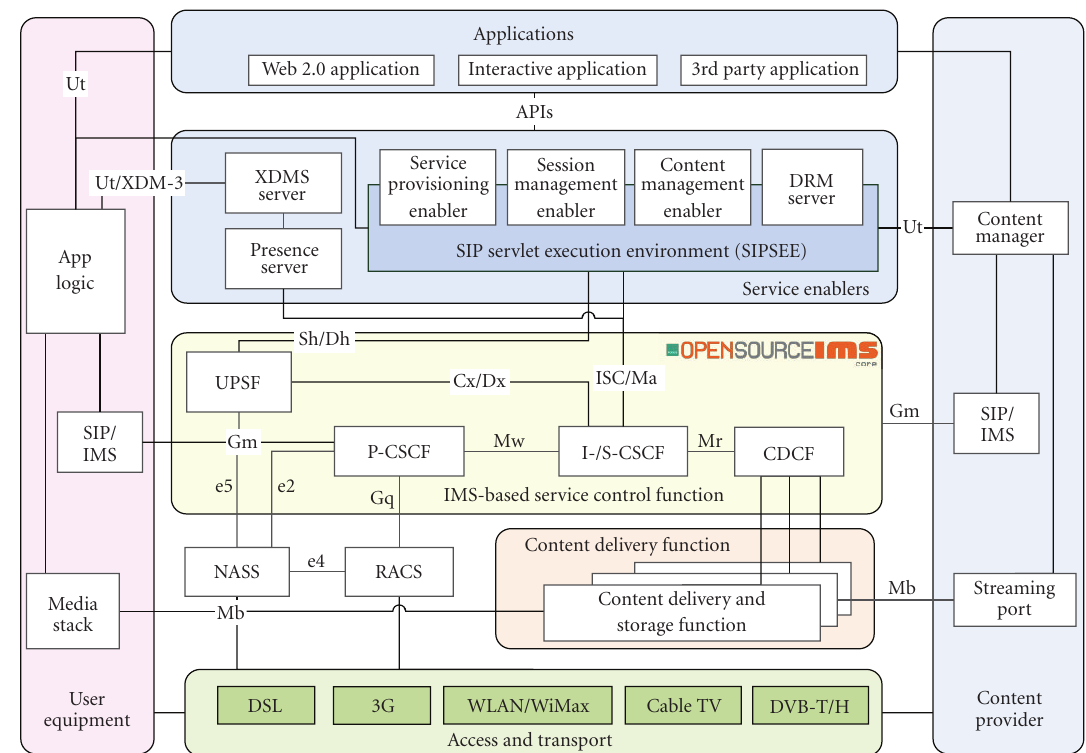
Figure 2: Reference implementation at the